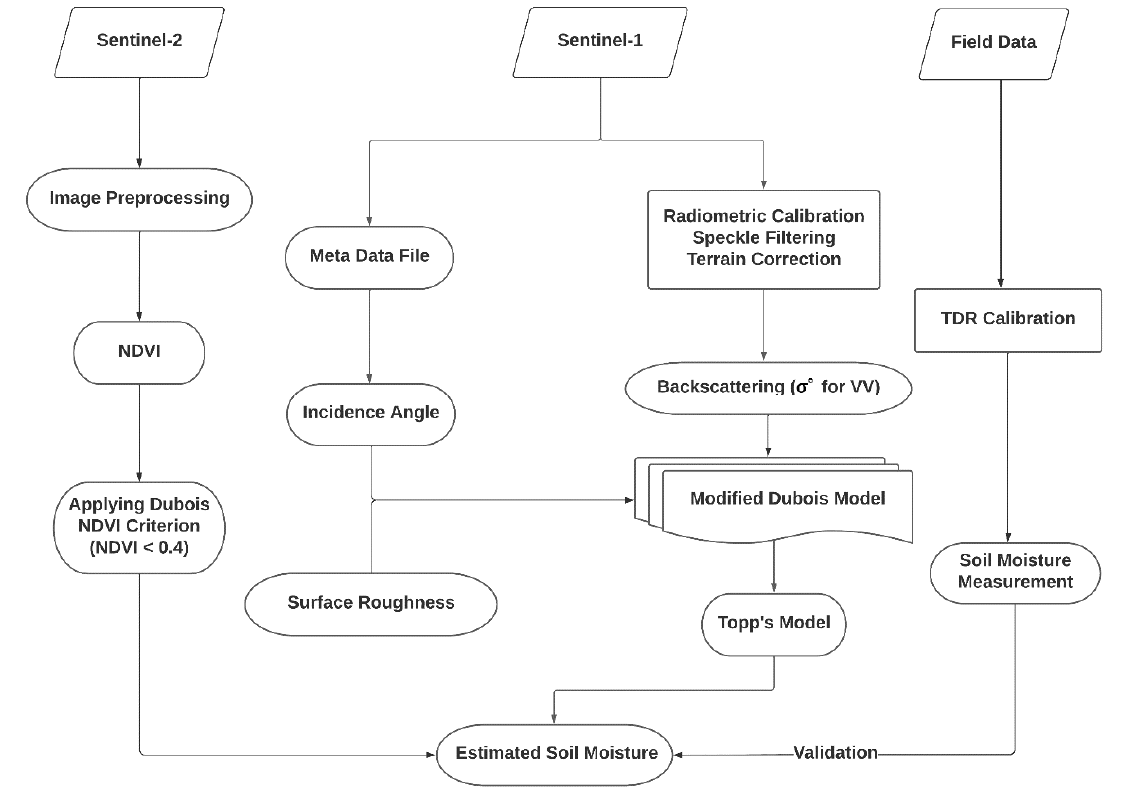
Figure 3. The flow chart illustrates the methodology used for the estimation of soil moisture from Sentinel-1 images.